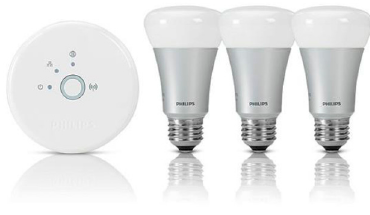
Figure 8. The Philips Hue.